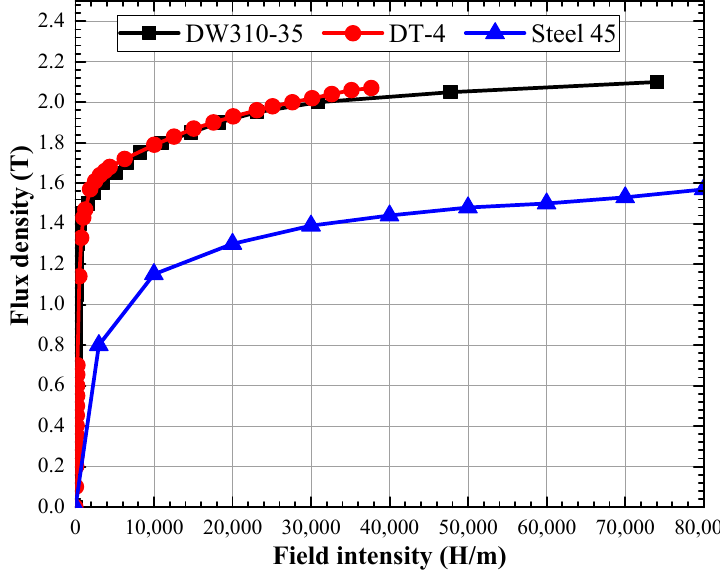
Figure 4. Magnetizing curves of the ferromagnetic materials.